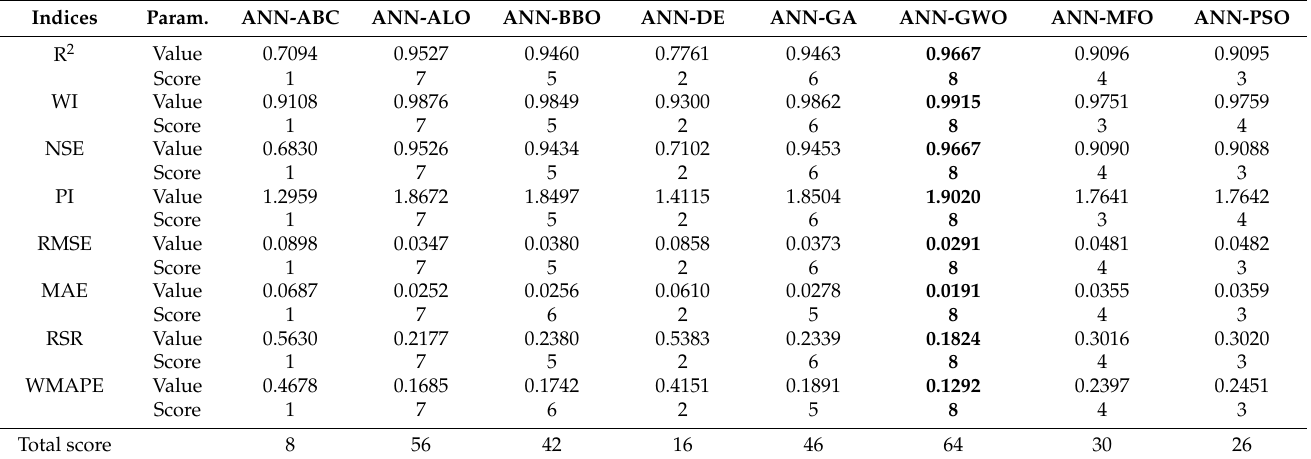
Table 6. Model performance in the training phase.